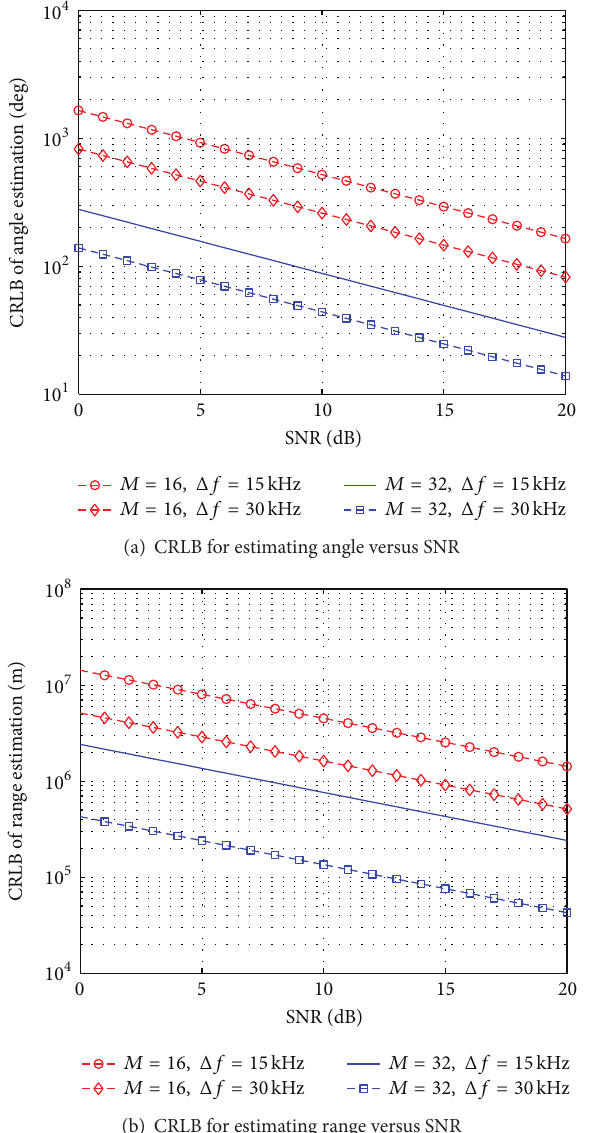
Figure 4: Both angle and range are unknown. Figure 5: CRLBs of TS-FDA radar with 𝑀 = 32